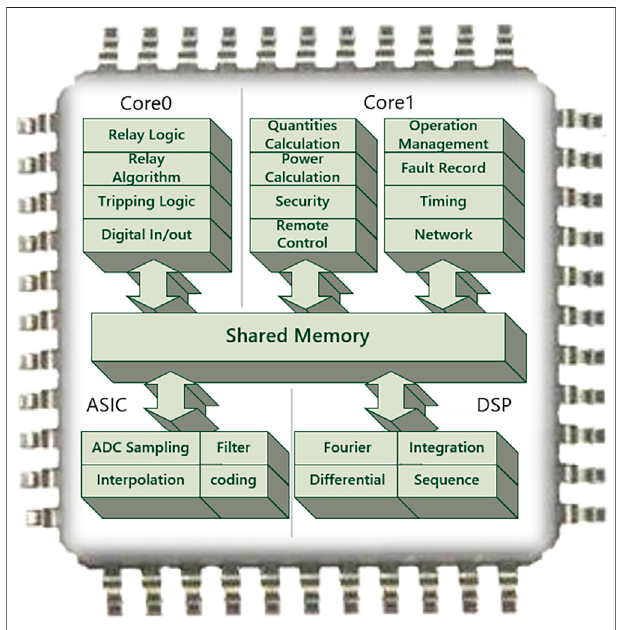
FIGURE 9 | Flow chart of distance protection program running on core0 of SoC chip for power system.